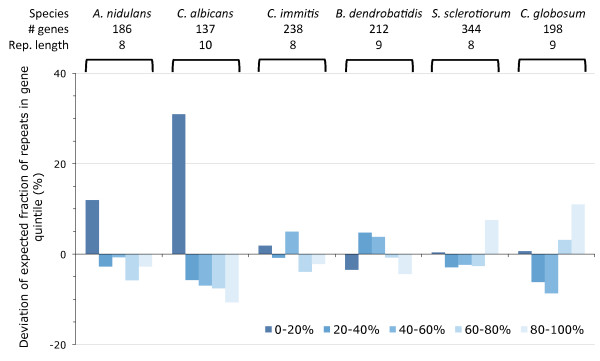
Six examples of repeat distribution profiles in the gene quintiles of fungal gene repertoires. Represented are the deviations of the expected value per quintile (i.e., 20%). # genes signifies the number of genes with mononucleotide repeats (per genome), and Rep. length signifies the length of the MNR in basepairs.